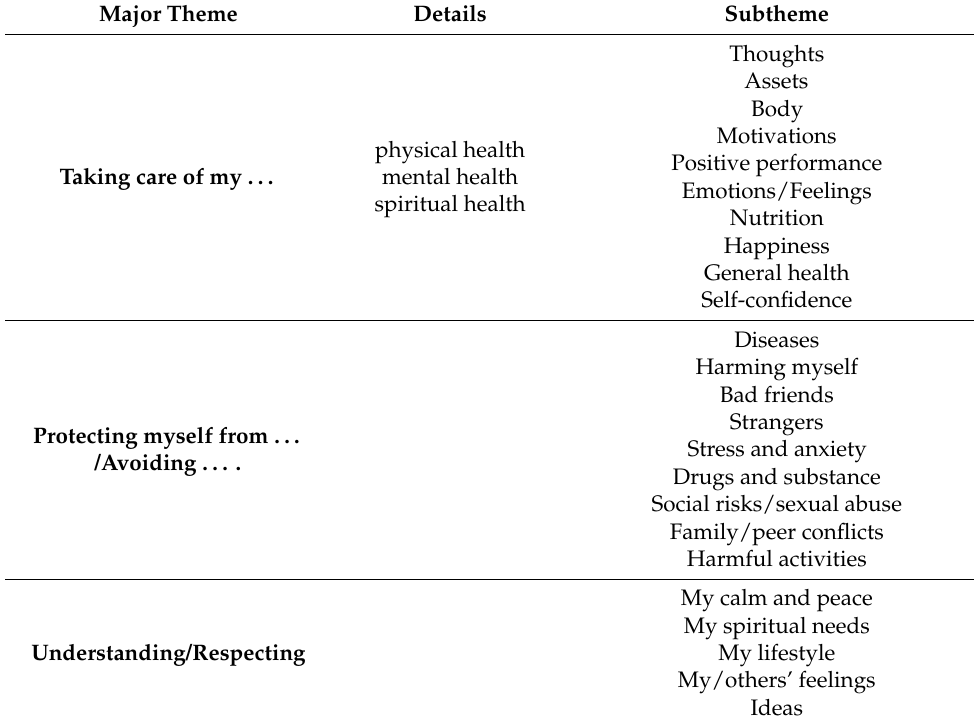
Table 3. Terms related to the participants’ definition/understanding of self-care